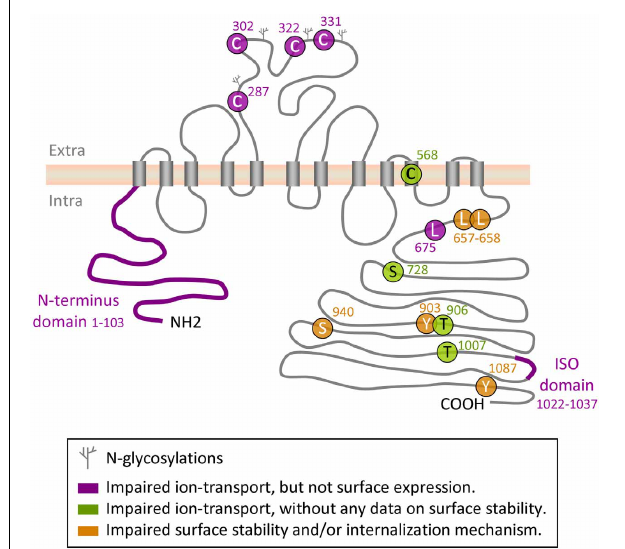
FIGURE 1 | Regulatory sites on KCC2 protein. Depicted is a schematic representation of the amino acid residues and domains in KCC2 that have been implicated in the control of intrinsic KCC2 transport activity or in its cell surface stability and/or membrane internalization.